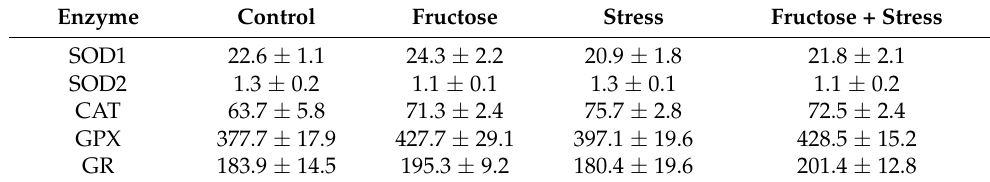
Table 2. Effects of liquid fructose supplementation and/or stress on antioxidant enzyme activity. Enzyme Control Fructose Stress Fructose + Stress SOD1 22.6 ±